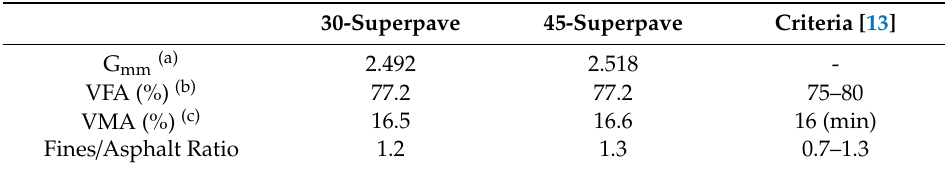
Table 1. Control mixes’